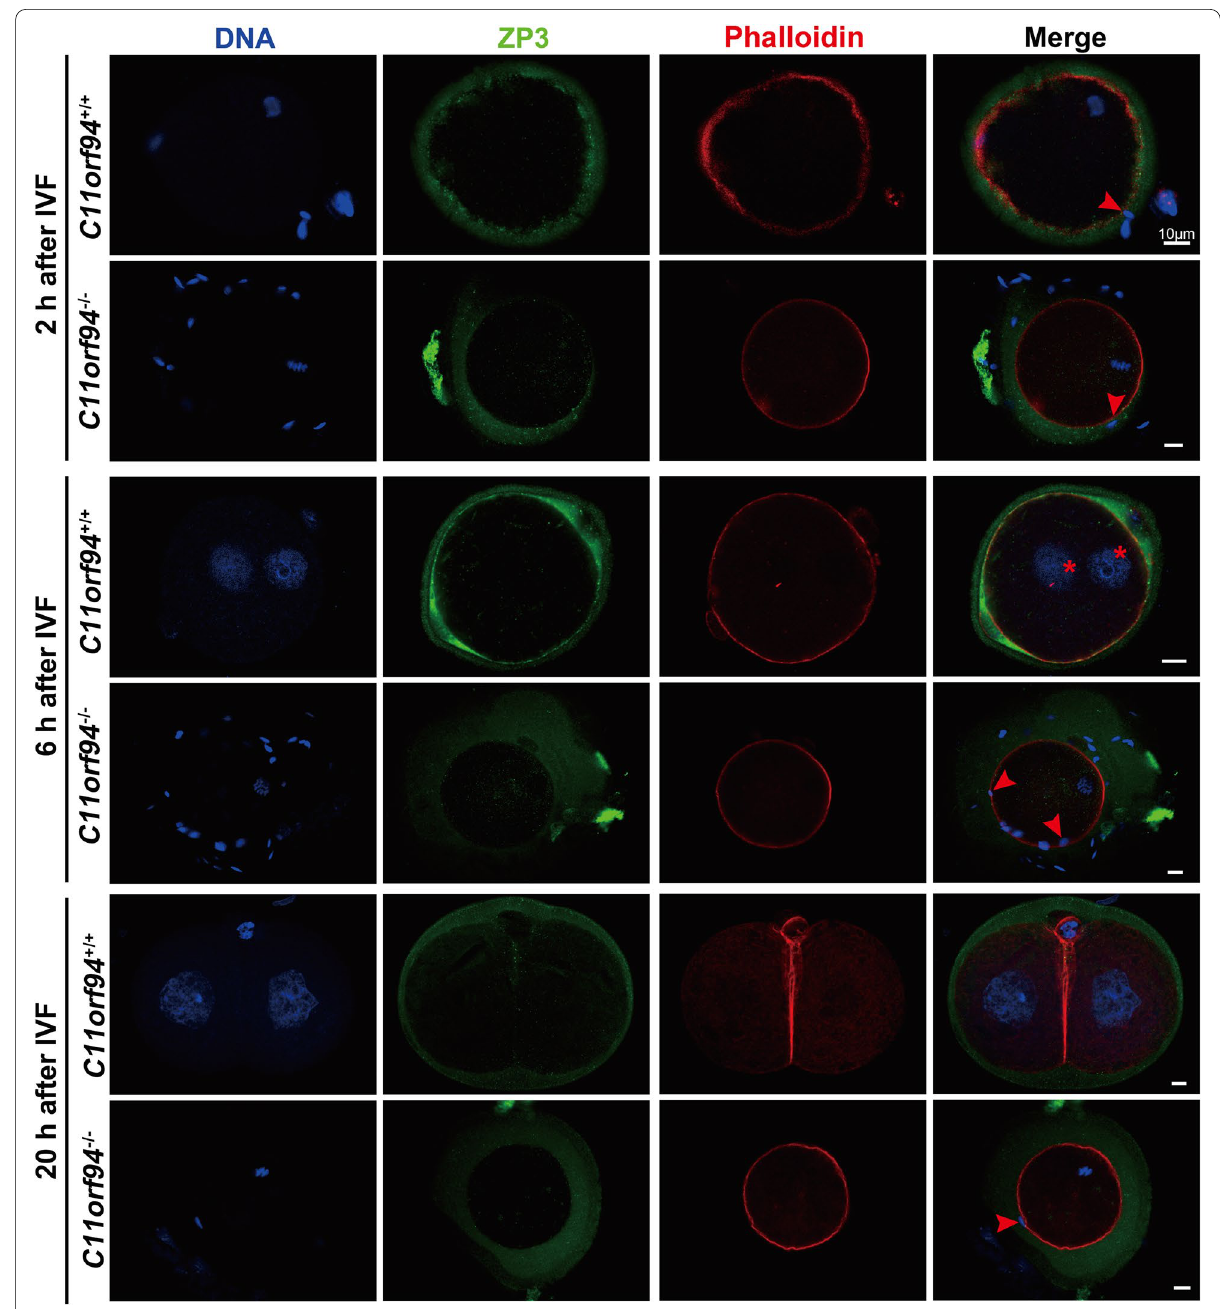
Fig. 5 The fertilization of sperm and oocytes at different times after IVF was detected by immunofluorescence. Cumulus-intact oocytes or fertilized oocytes were stained with anti-ZP3 (green) and anti-Phalloidin (red) antibodies. DNA was counterstained with Hoechst33342 as a marker of the cell nucleus. Red arrows indicate the heads of sperms and red asterisks indicate the male and female pronucleus. Scale bar, 100